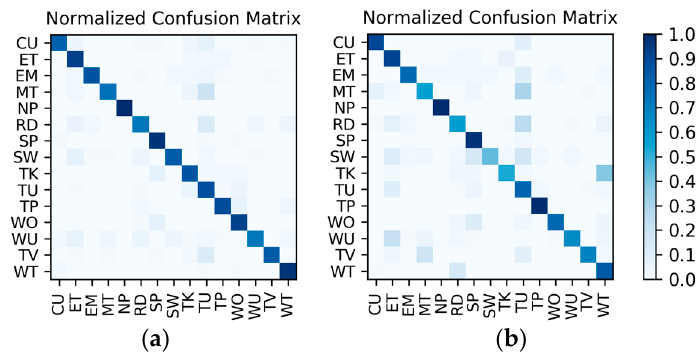
Figure 15. Confusion matrices for the hierarchical fusion results: ( a ) W1; ( b ) W2. Table 10. F 1 accuracy of the hierarchical fusion results.